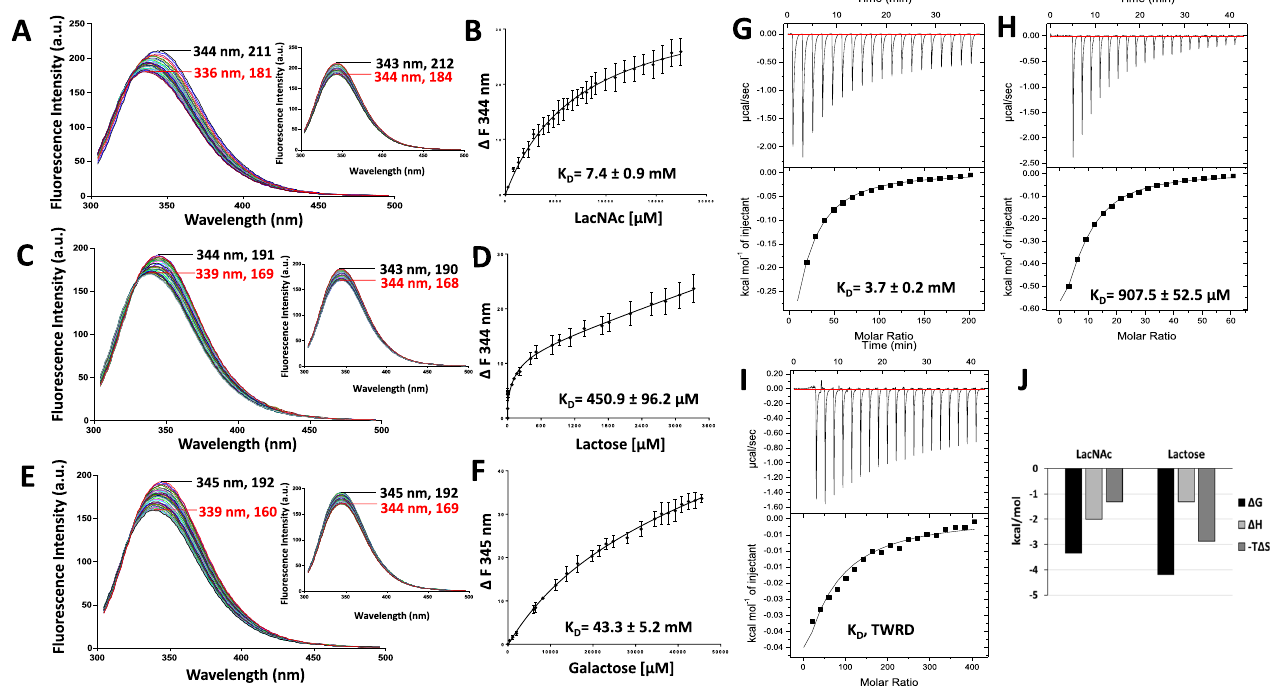
Figure 6. Determination of galectin-4N-ligand interactions by TFS and ITC. Galectin-4N (5 µ M) florescence intensity with increased concentrations of LacNAc ( A ), lactose ( C ) and galactose ( E ) were recorded by fluorescence spectroscopy. Numbers indicate the maximum fluorescence wavelength and corresponding fluorescence intensity for the first (no ligand/buffer titration, black) and last (red) titration traces. Inserts in each figure show buffer control titrations. Ligand concentrations vs changes in fluorescence intensity were plotted and analysed using One site- Specific binding model to obtain the binding affinities to LacNAc ( B ), lactose ( D ) and galactose ( F ). Heat changes for titration of galectin-4N (100 µ M) with 20 mM LacNAc ( G ), 30 mM lactose ( H ) and 200 mM galactose ( I ) were measured by ITC (upper panels) with data fit to One set of sites interaction model (bottom panels). Note the very small heat change by galactose which indicates very little, if any, binding taking place ( I ). Data were plotted as means ± SEM from three independent experiments for each assessment. Panel (J) shows thermodynamic profiles with enthalpy ( ∆ H), entropy ( ∆ S) and Gibbs free energy ( ∆ G) changes associated with galectin-4N binding to LacNAc and